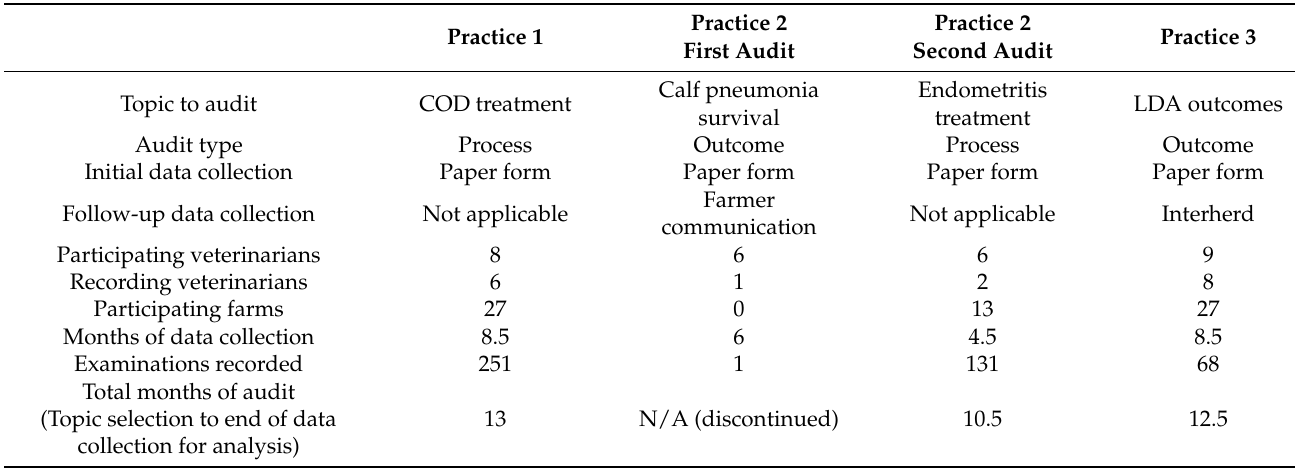
Table 3. Details of the three practices relevant to the prospective clinical audits carried out by each one over the course of the